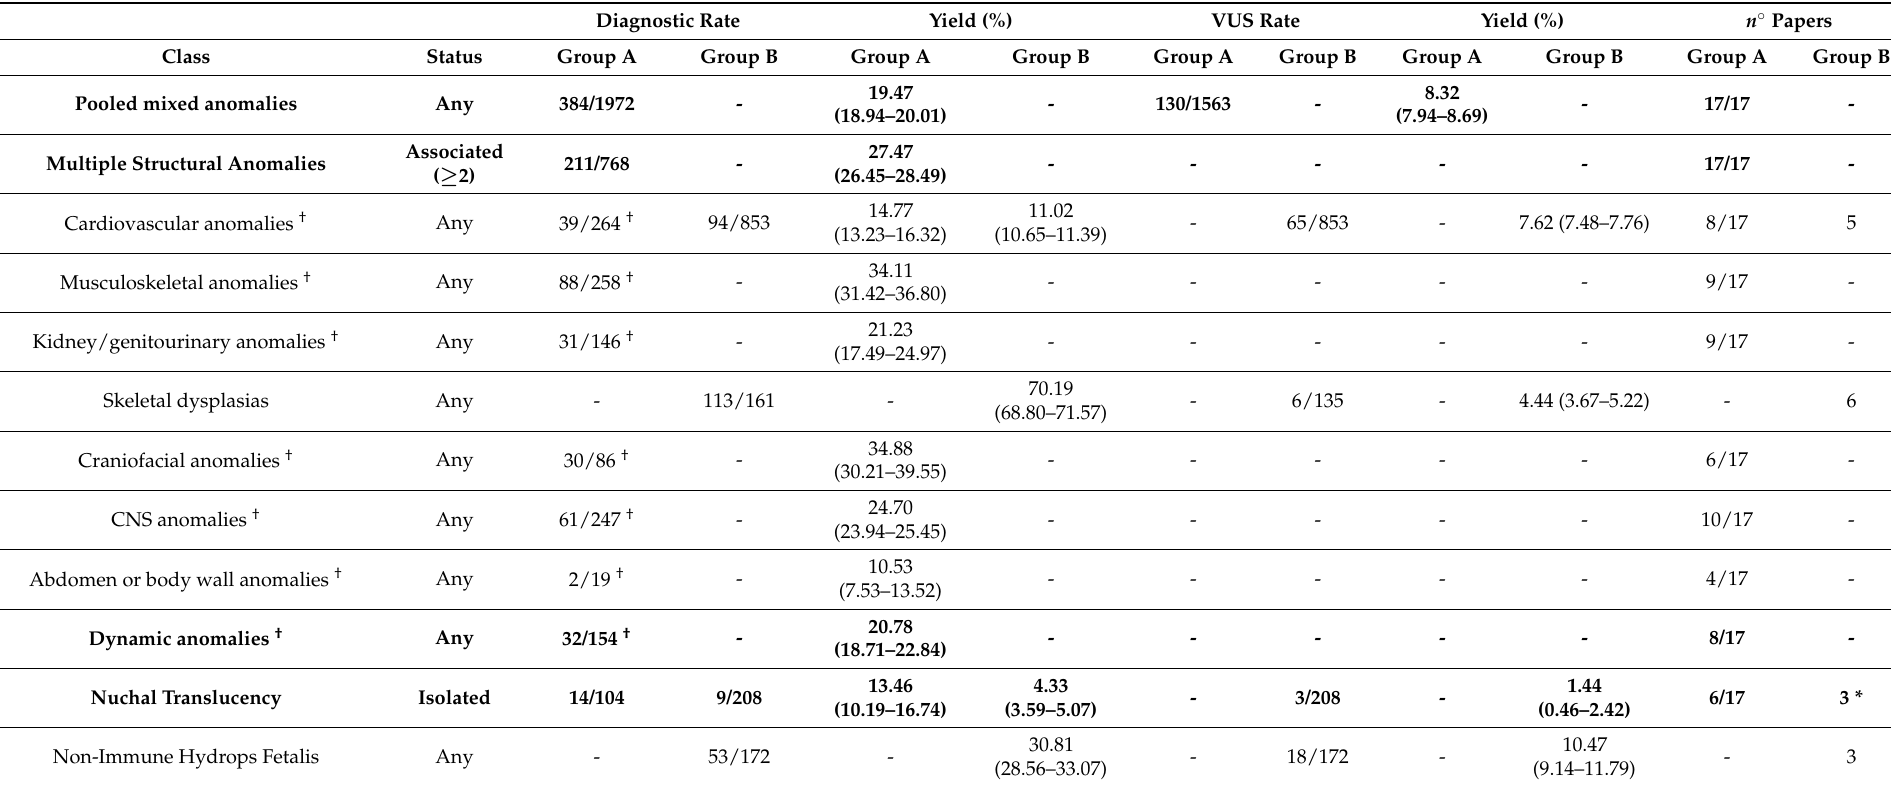
Table 3. ES meta-analysis. Any refers to cohorts pooling both isolated and associated anomalies. NIHF: non-immune hydrops fetalis; CNS: central nervous